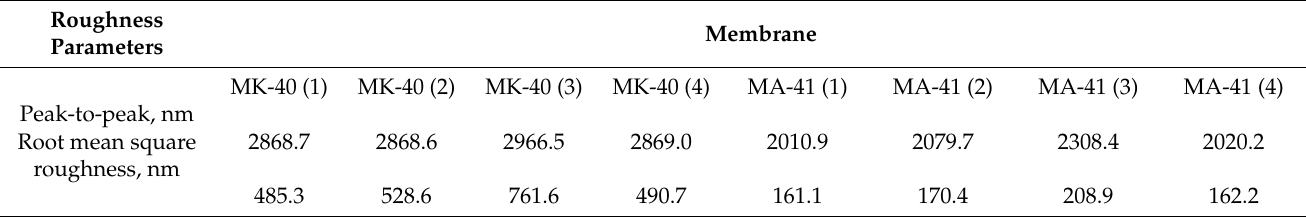
Figure 2. Current-voltage characteristics of the MK-40 cation-exchange membrane in the electrodi- alysis of Trp + NaCl ( a ) and Pro + NaCl ( b ) solutions: 1—pristine membrane, 2—regenerated membrane, 3—fouled membrane; 4—pristine membrane in the ED of NaCl solution. Table 3. Roughness parameters of the ion-exchange membranes in different forms: H + -form of MK-40 and OH − -form of MA-41 (1), Pro-form (2), fouled membrane during electrodialysis of Pro containing solution (3), regenerated membrane (4).